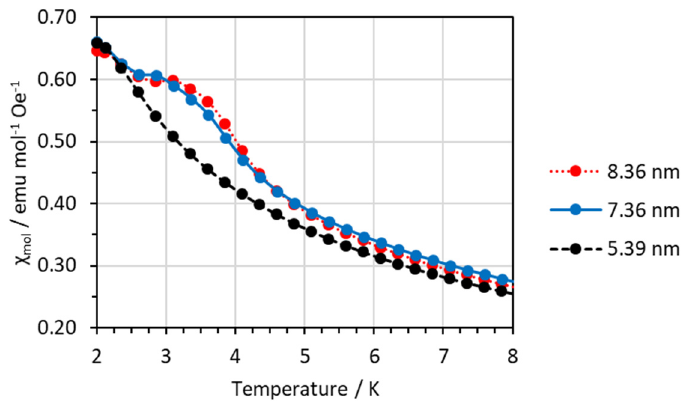
Figure 5. Temperature-dependent, zero-field-cooled molar magnetic susceptibilities for [C 2 mim]FeCl 4 confined in silica 1 (red dotted line, 8.36 nm), silica 2 (blue solid line, 7.36 nm), and silica 3 (black dashed line, 5.39 nm).